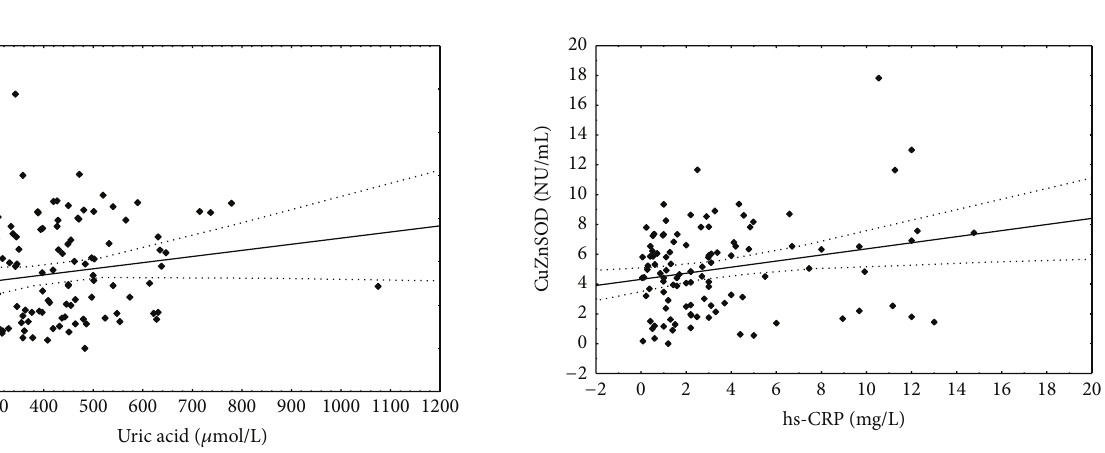
Figure 7: Correlation between hs-CRP concentration and